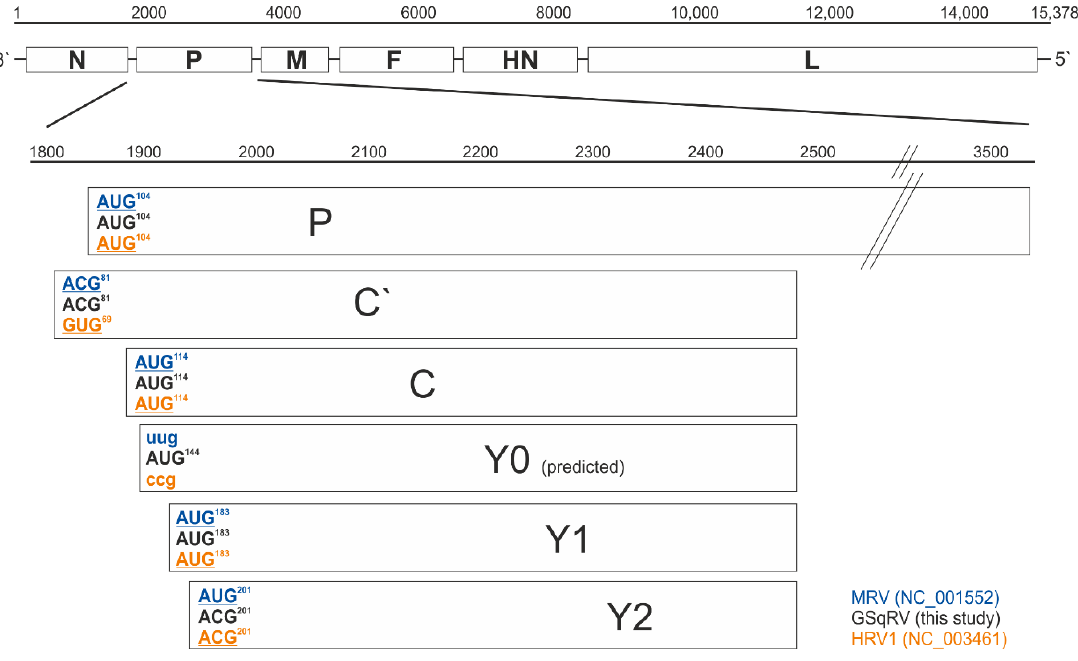
Figure 3. Schematic representation of the coding sequences (CDS) located in the P gene including the new open reading frame (ORF) Y0 in the GSqRV genome. The P mRNA transcript serves as template for the synthesis of the phosphoprotein and the accessory proteins located in the +1 ORF, accessible through a ribosomal scanning mechanism. The superscript numbers indicate the position of the first base of the start codon relative to the 5 ′ end of the mRNA; blue: murine respirovirus (MRV), strain Nagoya (NC_001552), black: GSqRV (this study), orange: human respirovirus 1 (HRV1), strain Washington/1964 (NC_003461); underlined: protein expression was verified by others [39,41,42], lower case: non-start codons at the corresponding position.